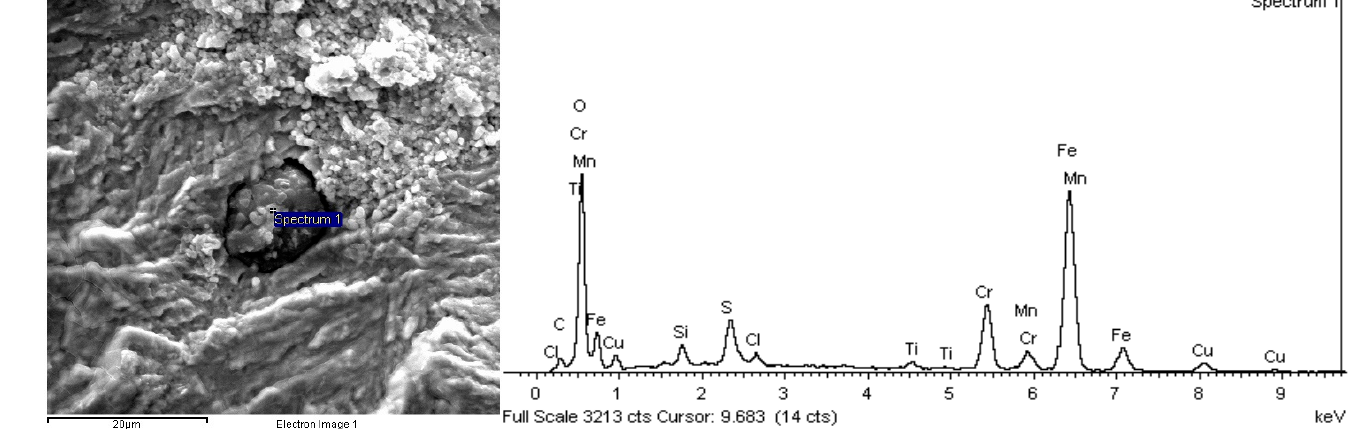
Figure 8. Energy spectrum analyses of KMN-I large specimen inclusion.